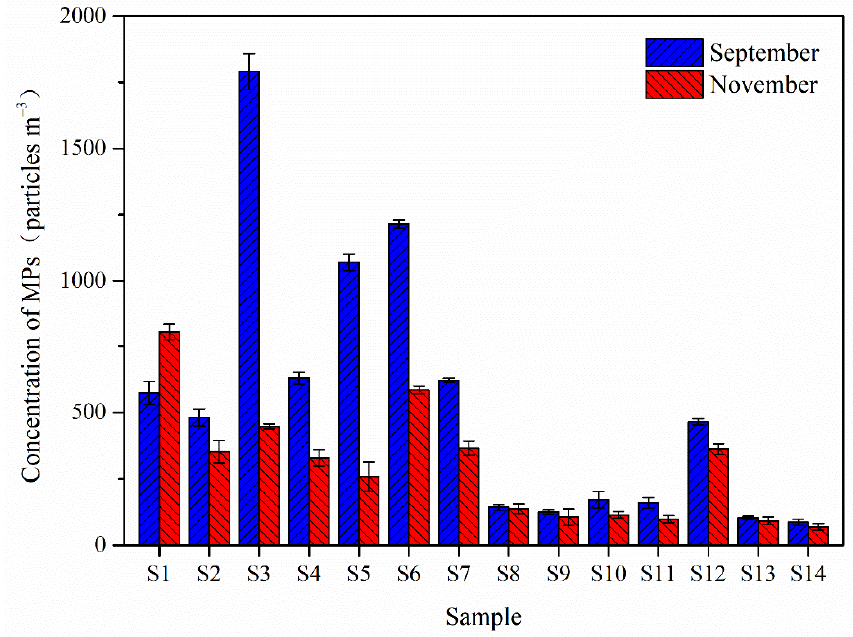
Figure 2. Concentrations of MPs in a coastal region of the PRE in rain and dry season.